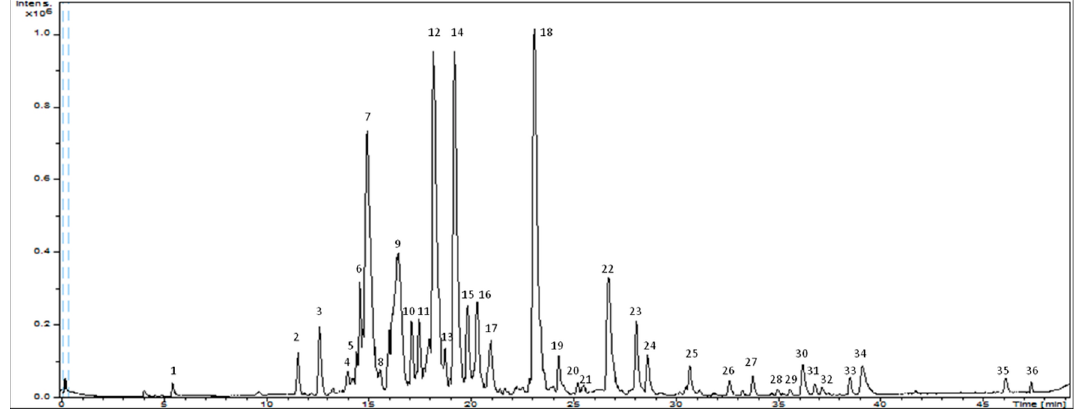
Figure 2. Base peak chromatogram of grape seed extract.